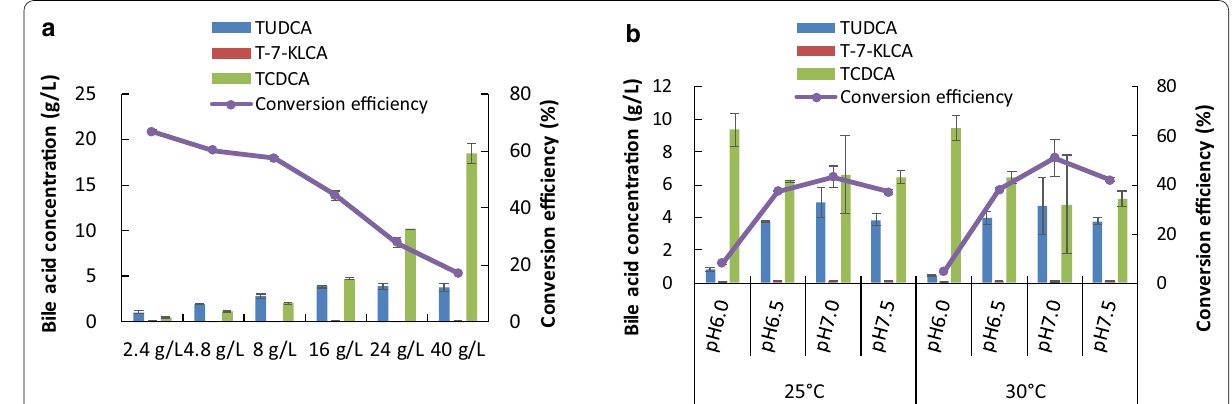
Fig. 3 Results of substrate concentration and pH value on the biotransformation of TUDCA. a Results of substrate concentration when incubation at 30 °CC, pH6.5 for 9 h. b Results of pH value when incubation for 9 h